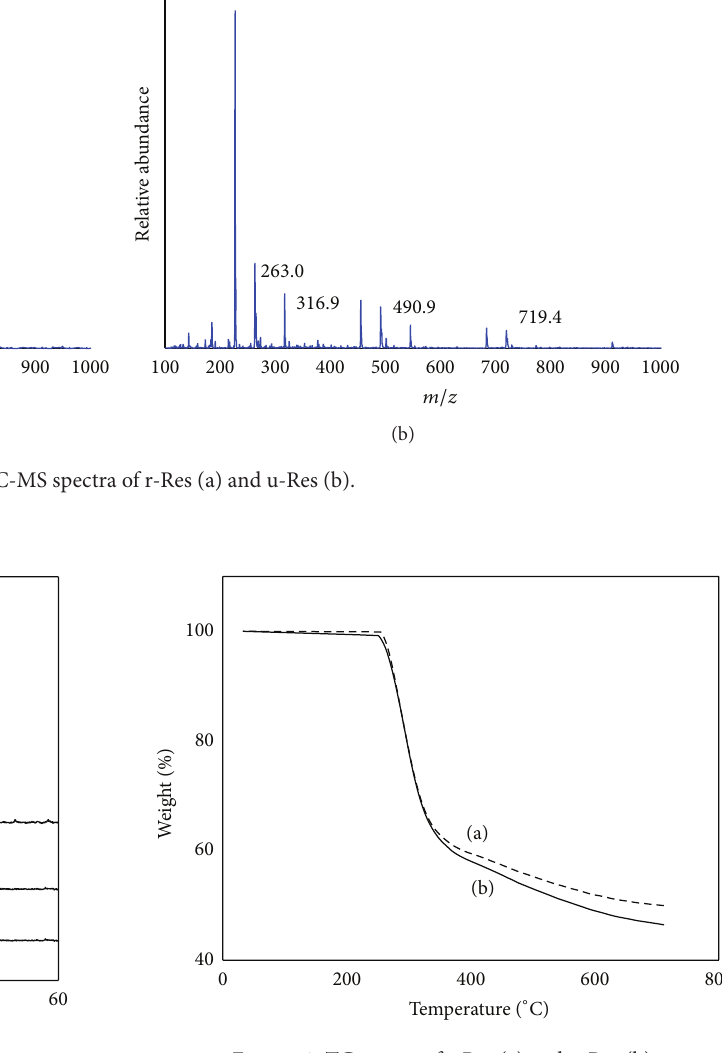
Figure 7: XRD patterns of r-Res (a), u-Res (b), and u-Res (c) which was placed 3 months.